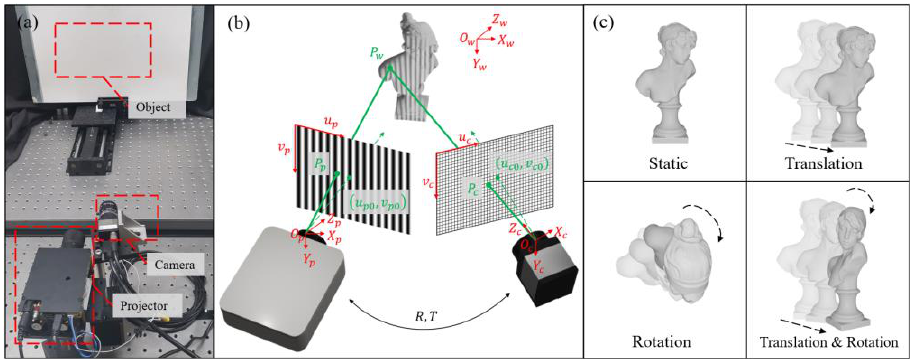
Figure 2. Dataset establishment in virtual FPP system. ( a ) Experimental setup of actual FPP system. ( b ) Schematic diagram of virtual FPP system. ( c ) Different motion types used in synthetic data generation.